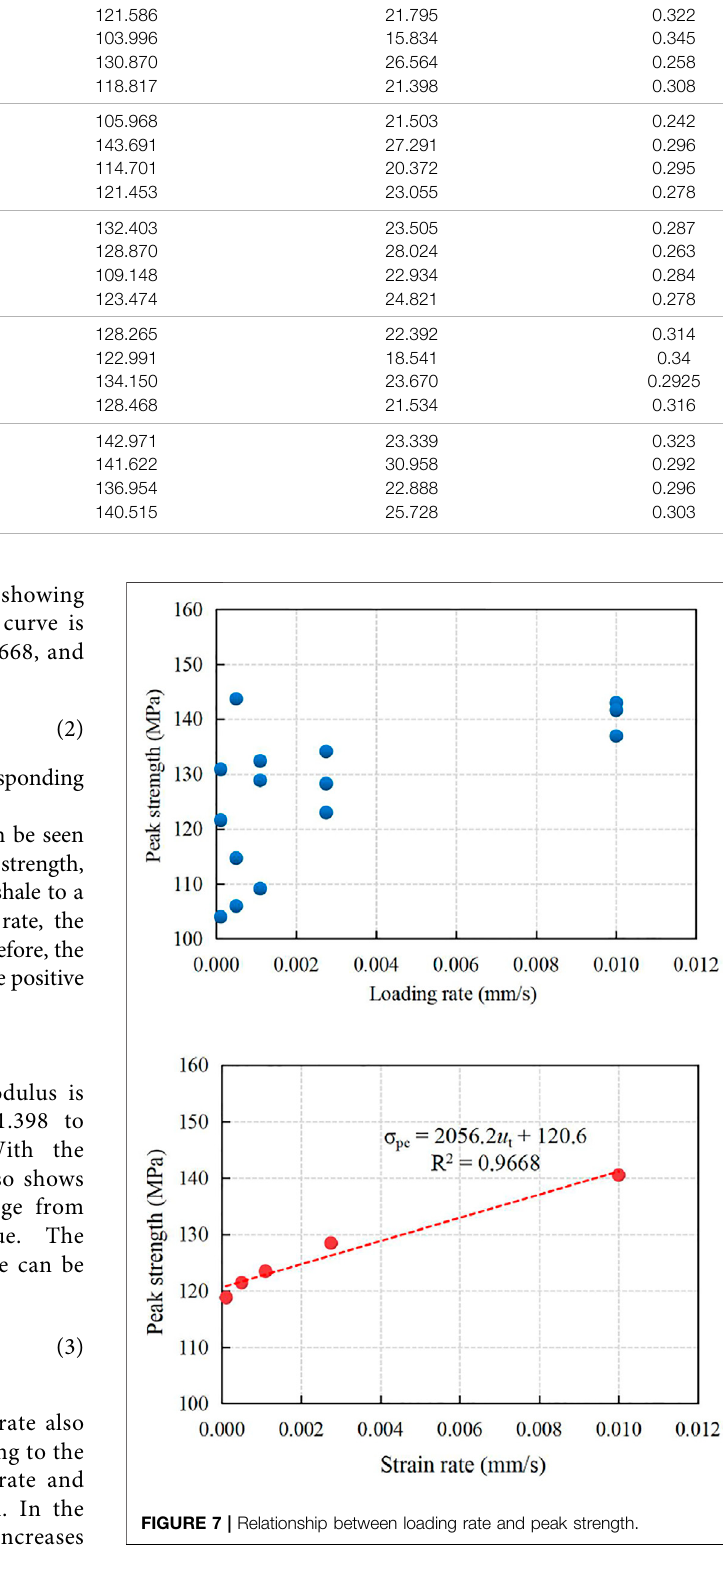
TABLE 3 | Uniaxial compression test results of shale samples. Shale sample number